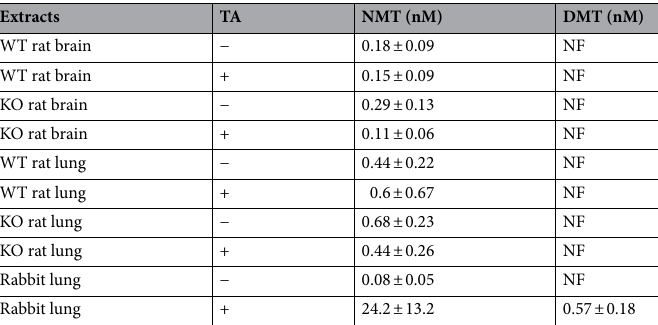
Extracts TA NMT